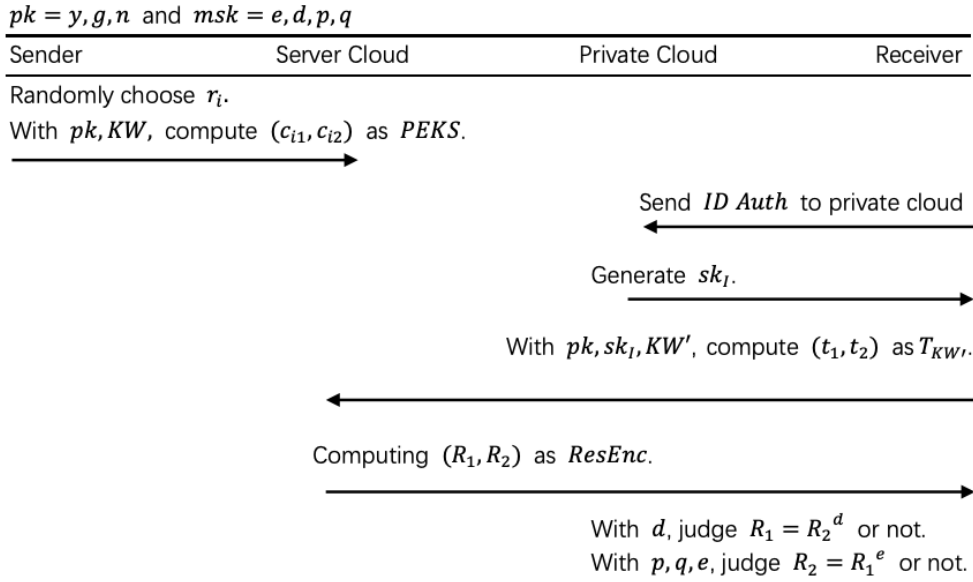
Figure 7. Flow of